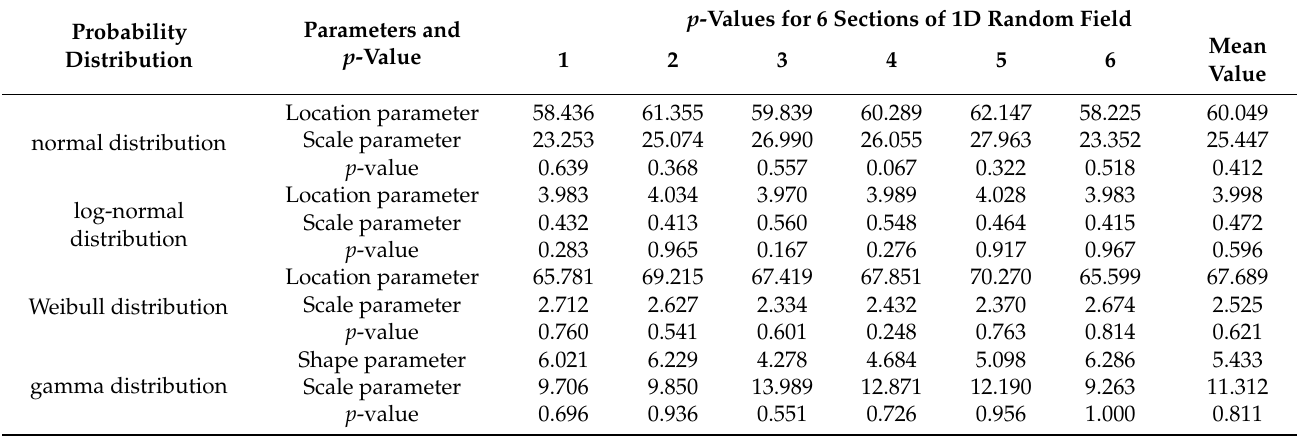
Table 3. Pointwise parameters estimation for the nano-modulus of the bulk